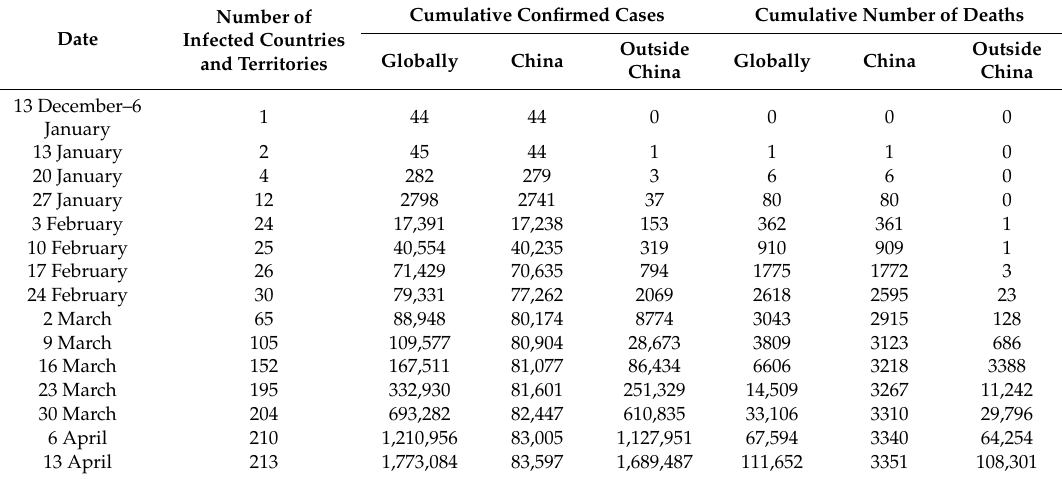
Table 4. Number of confirmed cases, deaths, and infected countries inside and outside China weekly